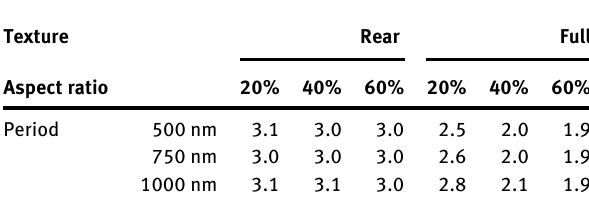
Table 4: Effect of aspect ratio AR and period P of sinusoidal nanotextures on the photon-current density J ph , refl lost by reflection. Results are shown for devices with a rear-side textured or fully textured perovskite top cell, as illustrated in Figure 2(a). For these simulations, the layer thicknesses were as in Table 3, except the perovskite thickness, which was adjusted to reach current matching using Newton’s